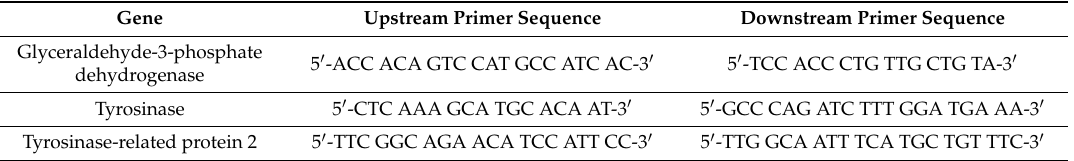
Table 3. Primers used for reverse transcription real-time quantitative polymerase chain reaction. Gene Upstream Primer Sequence Downstream Primer Sequence Glyceraldehyde-3-phosphate